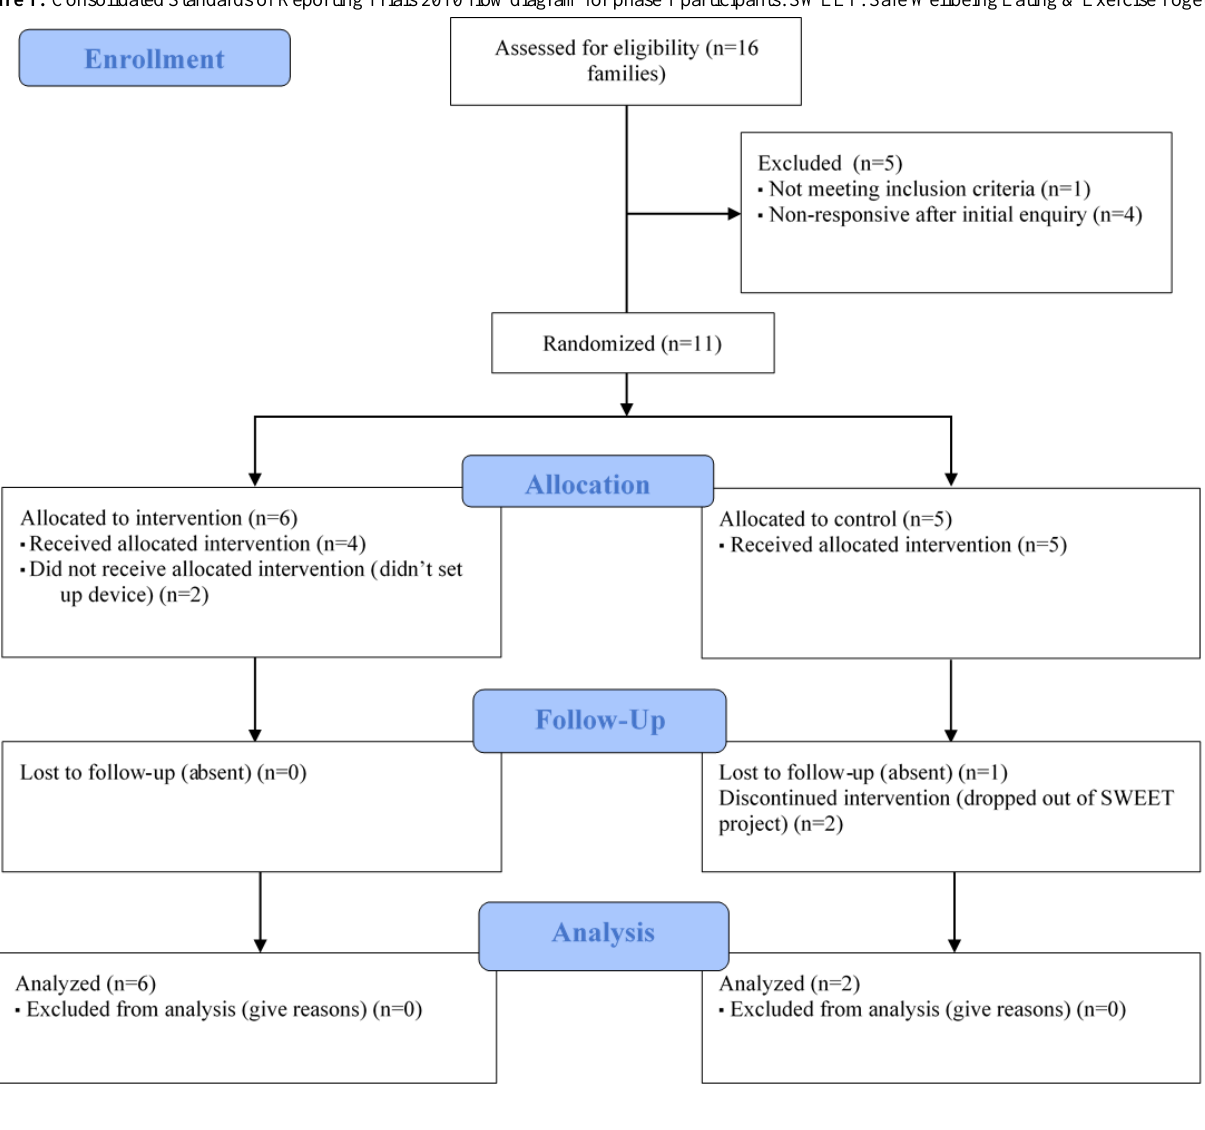
Table 2. Individual participant characteristics at